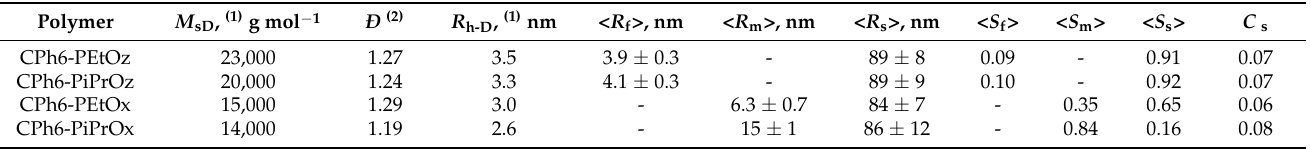
Table 1. Molar masses and average values of hydrodynamic radii of scattering object in aqueous solutions of investigated stars-shaped CPh6-PAlOx and CPh6-PAlOz.